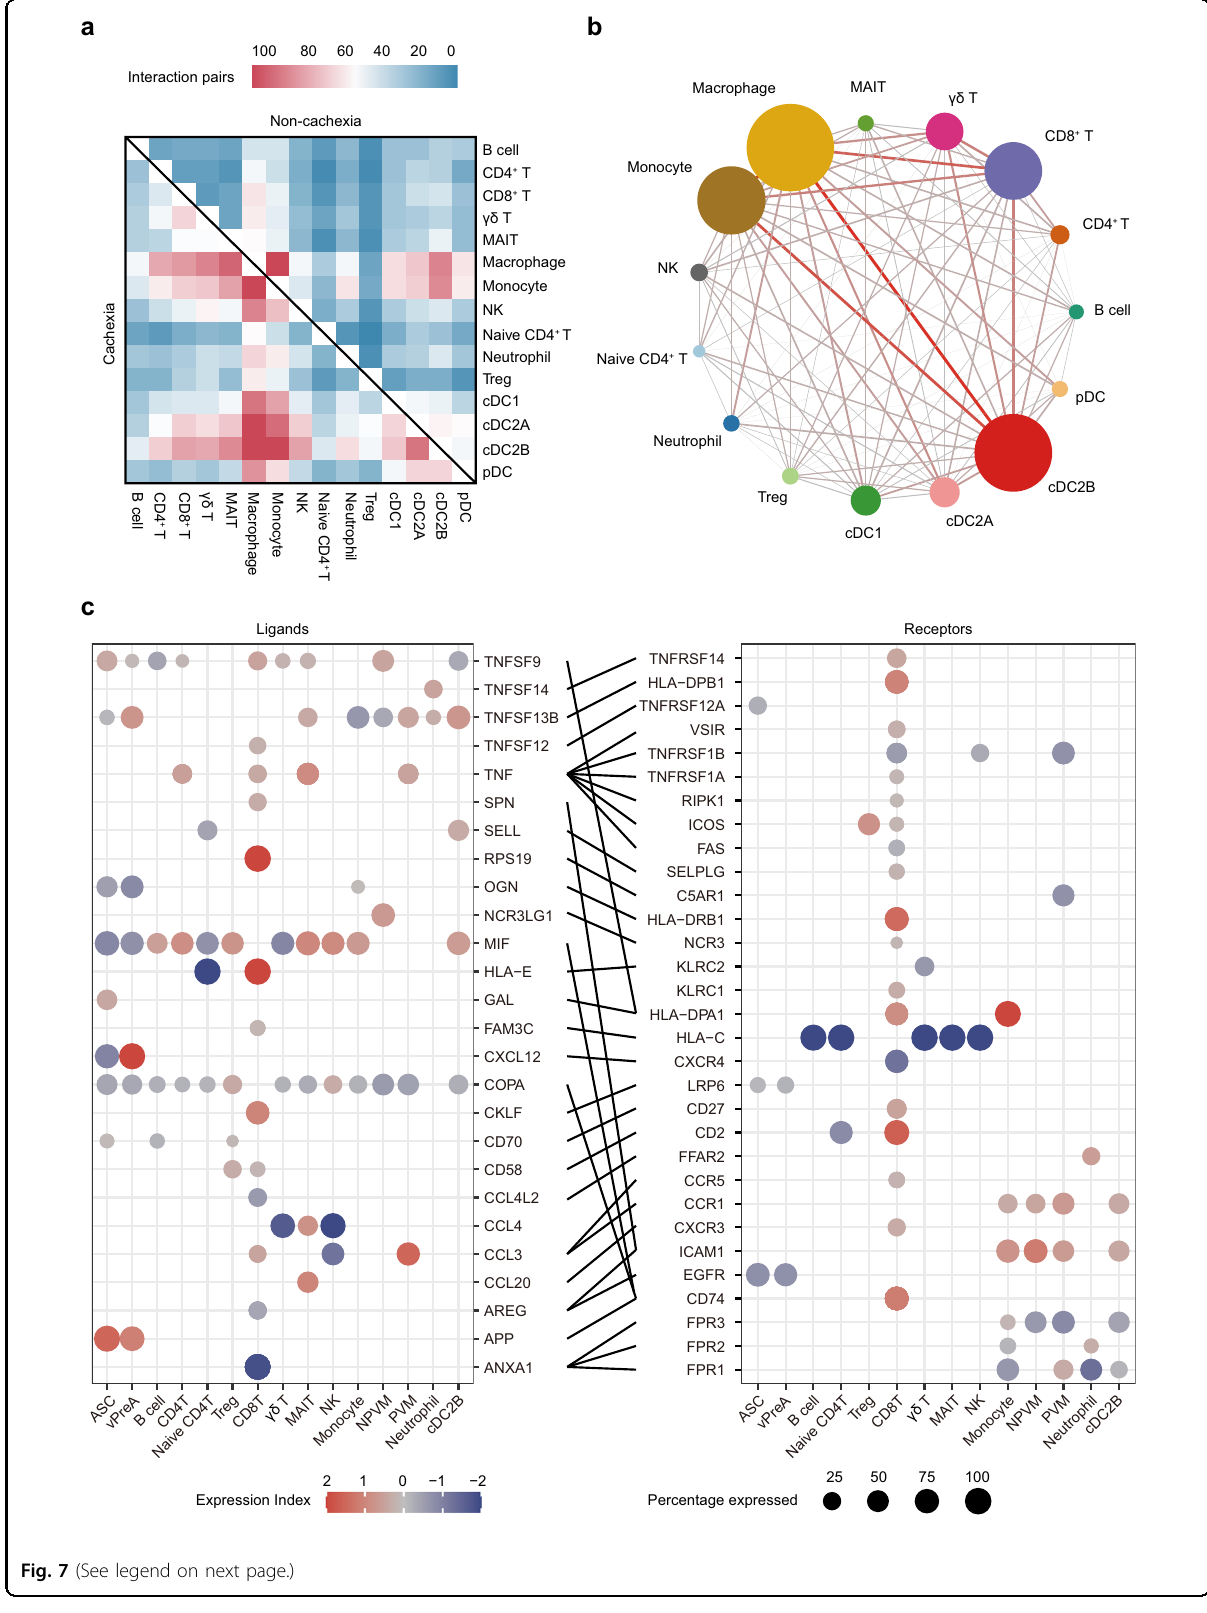
Fig. 7 (See legend on next